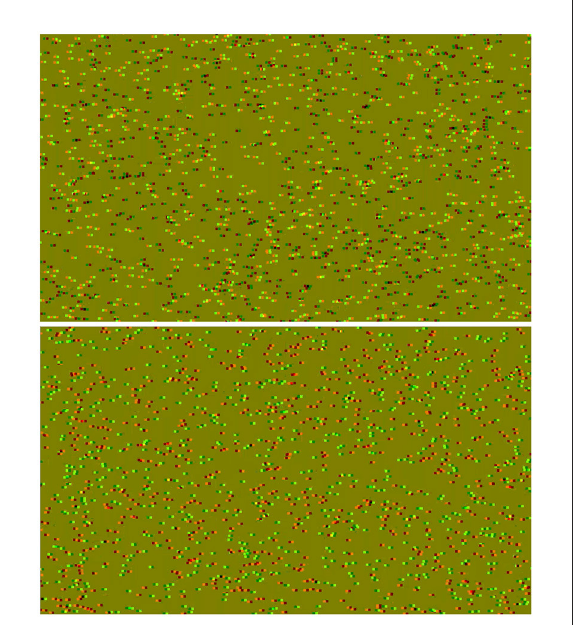
FIGURE1 Anaglyph stereograms, rendered to be viewed with red-green glasses. Top: A correlated stereogram. Bottom: An anticorrelated stereogram. Both of these stereograms have the same horizontal bars encoded as depth